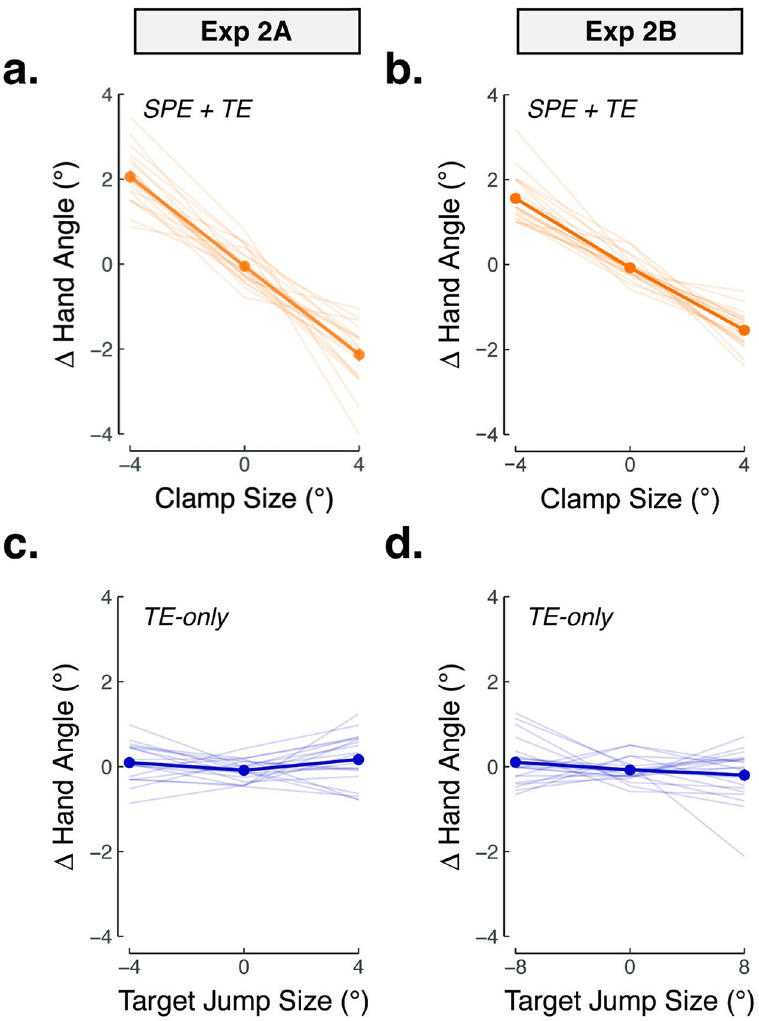
Fig 3. Task error alone does not elicit implicit recalibration (Exp 2). (a)–(b) Participants experienced a fully randomized (mixed) schedule of clamped feedback trials (Set A and Set B were both with ± 4˚ SPE + TE perturbations) and (c)–(d) target jumps (Set A with ± 4˚ TE-only perturbations and Set B with ± 8˚ TE-only perturbations). Dots connected with thick line represent the across participant average; thin lines represent individual